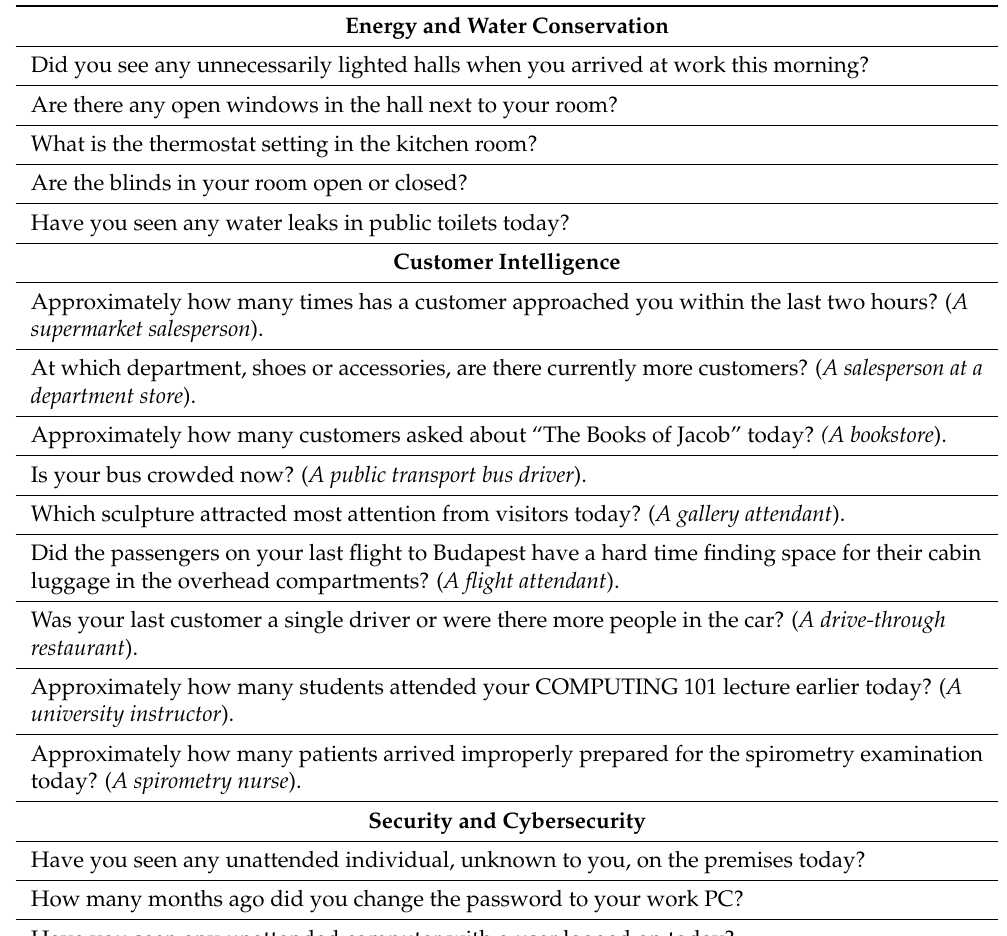
Table 1. Examples of sensing requests in different “application